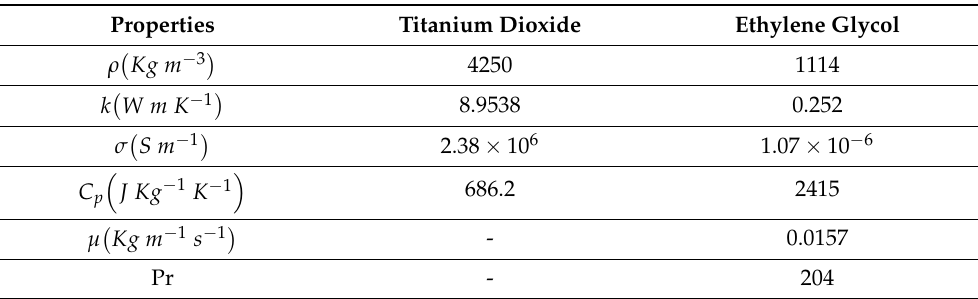
Table 1. Thermophysical properties for titanium dioxide and base fluid (Ethylene glycol) (see Mackolil and Mahanthesh [45]).